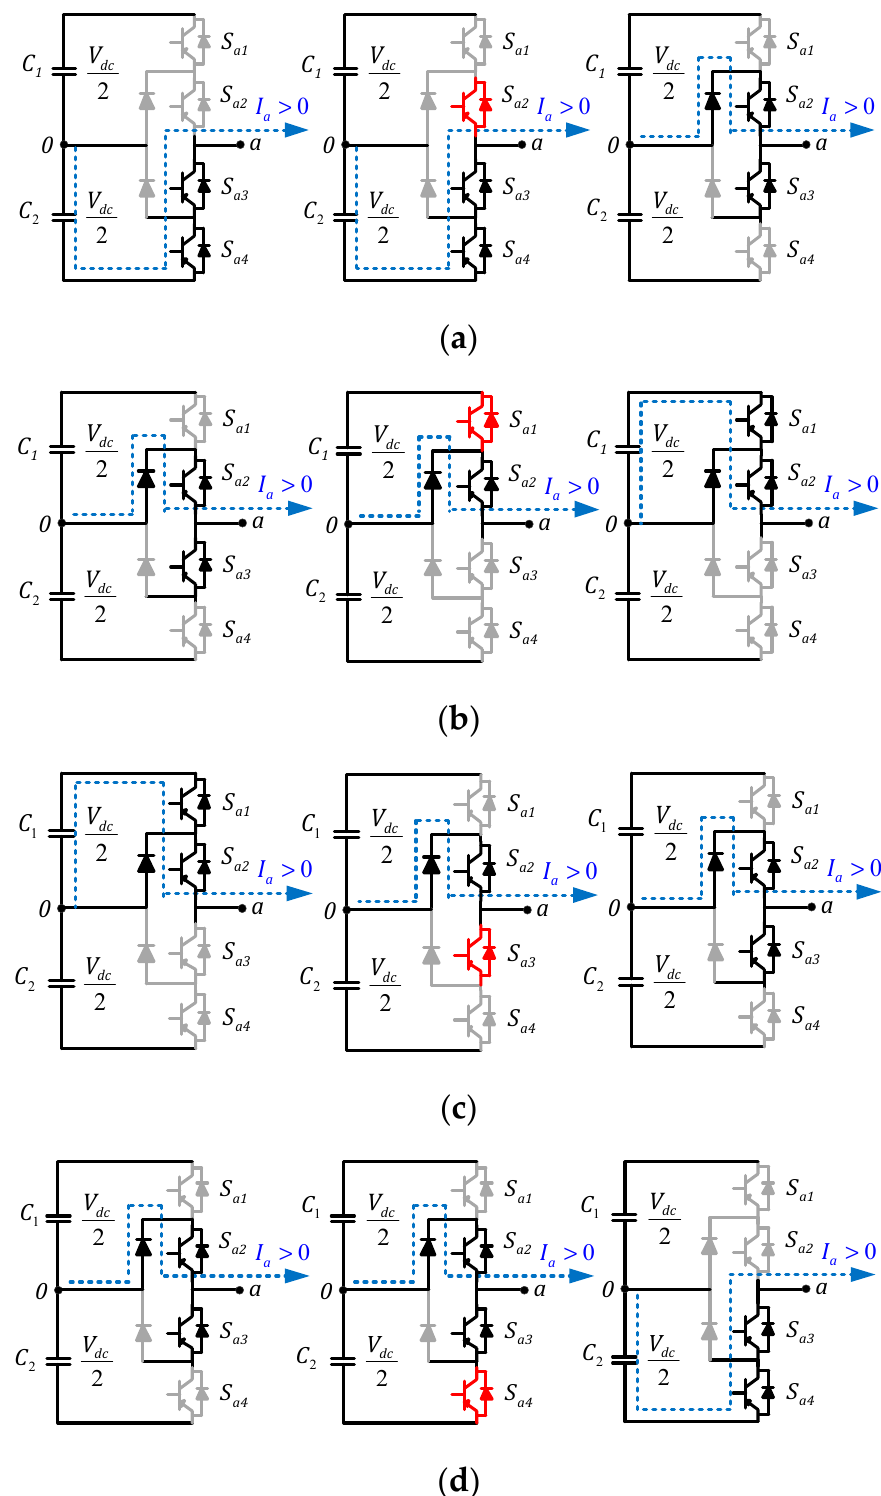
Figure 10. Transient state of switching at positive current: ( a ) From − V dc / 2 to 0; ( b ) from 0 to + V dc / 2; ( c ) from + V dc / 2 to 0; ( d ) from 0 to − V dc / 2 [2].